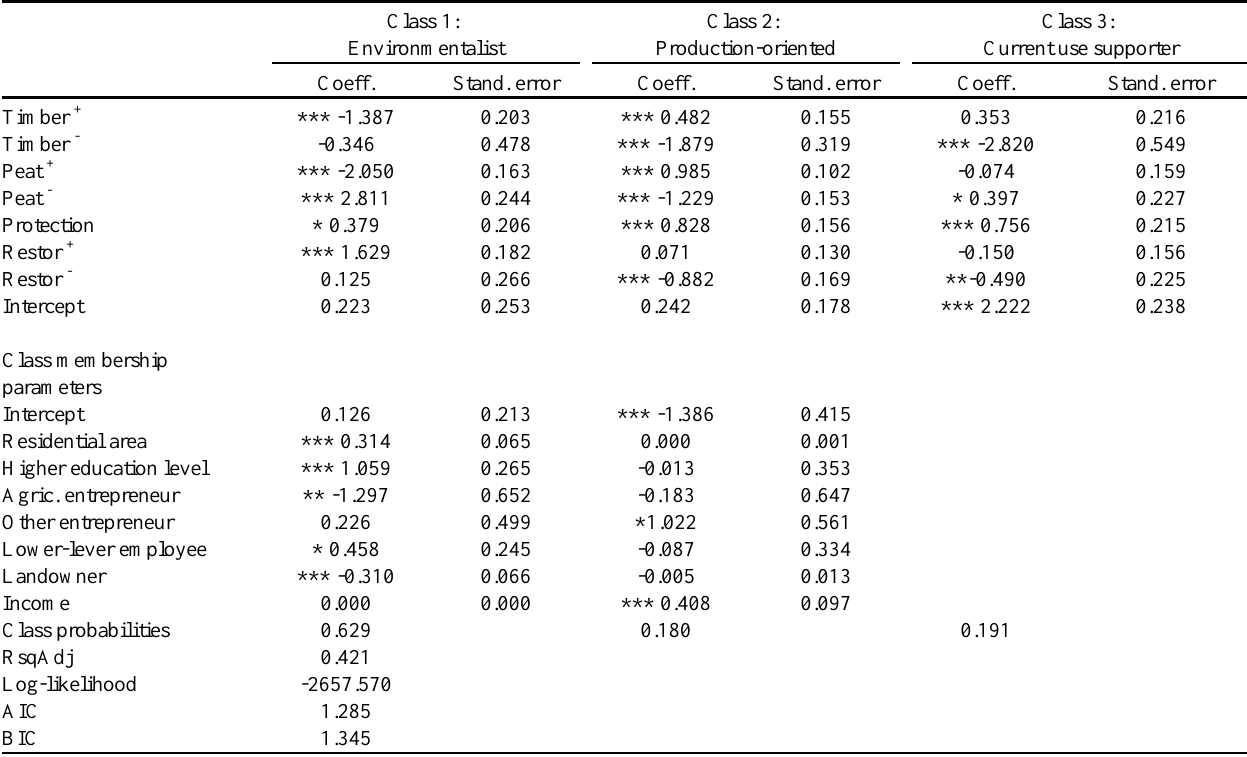
Table 2 . Results from the three-class latent class model (LCM) including socioeconomic explanatory variables for class membership. The class membership coefficients for Class 3 were fixed to identify the remaining coefficients. Number of respondents =